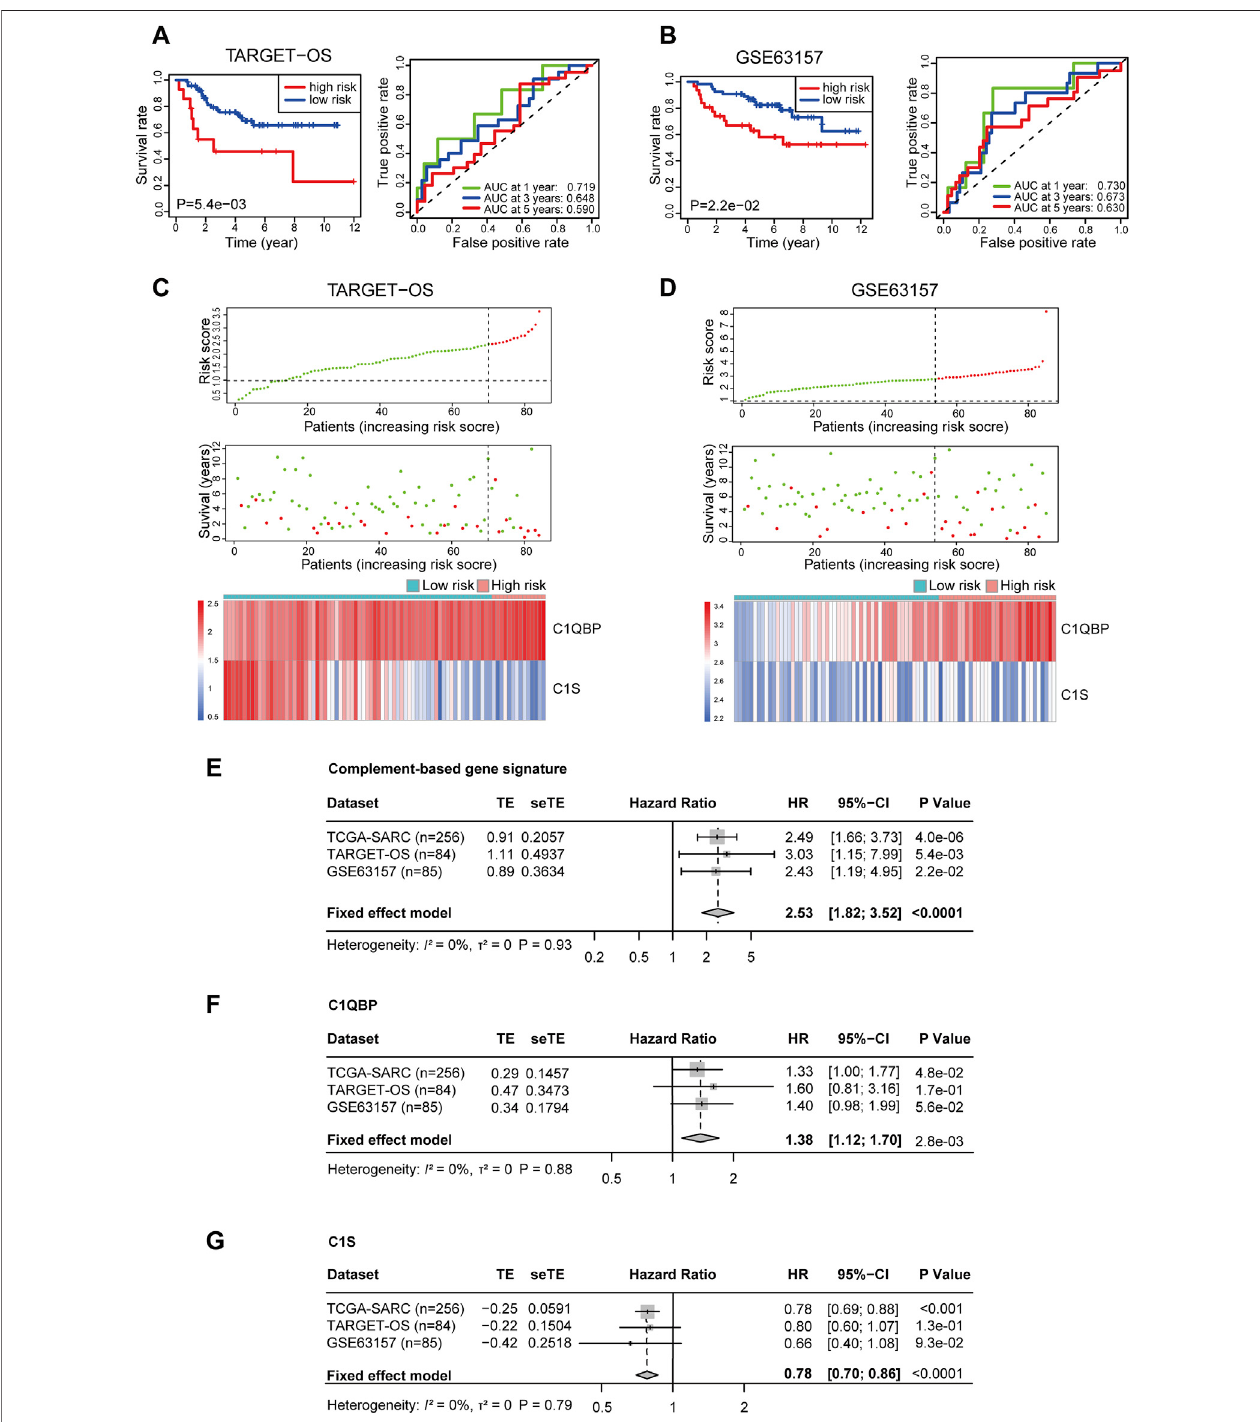
FIGURE 2 | Validation of the complement-related gene signature for predicting overall survival in TARGET-OS, GSE63157, and meta-analyses of the performances. Survival curve and ROC (A) , risk score distribution, survival status, and the two-gene expression panel (C) in TARGET-OS. Survival curve and ROC (B) , risk score distribution, survival status and the two-gene expression panel (D) in GSE63157. Meta-analyses of prognostic values of complement-related gene signature (E) , C1QBP (F) and C1S (G) in sarcoma patients from three databases. p values of TCGA-SARC ( n = 256), TARGET-OS ( n = 84) GSE63157 ( n = 85) were calculated by Kaplan-Meier analyses. p value of all included ( n = 425) patients was calculated by meta-analyses. TARGET-OS, the osteosarcoma cohort from the TARGET database; ROC, receiver operating characteristic curve; AUC, area under the curve; TCGA, The Cancer Genome Atlas; TCGA-SARC, the whole TCGA sarcoma cohort; TE, estimate of treatment effect; seTE, standard error of TE.